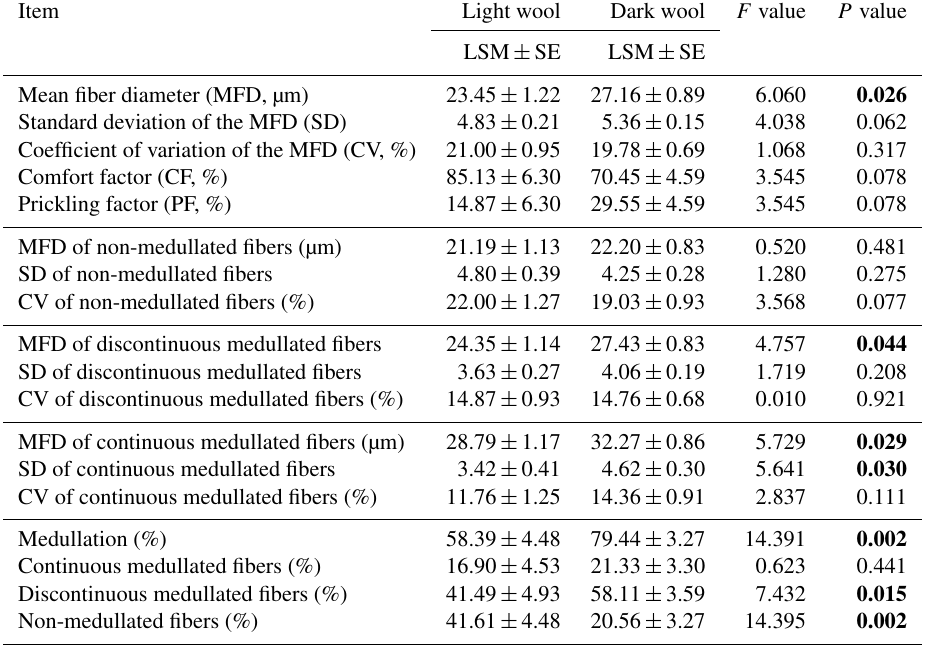
LSM represents the least squares mean, and SE represents the standard